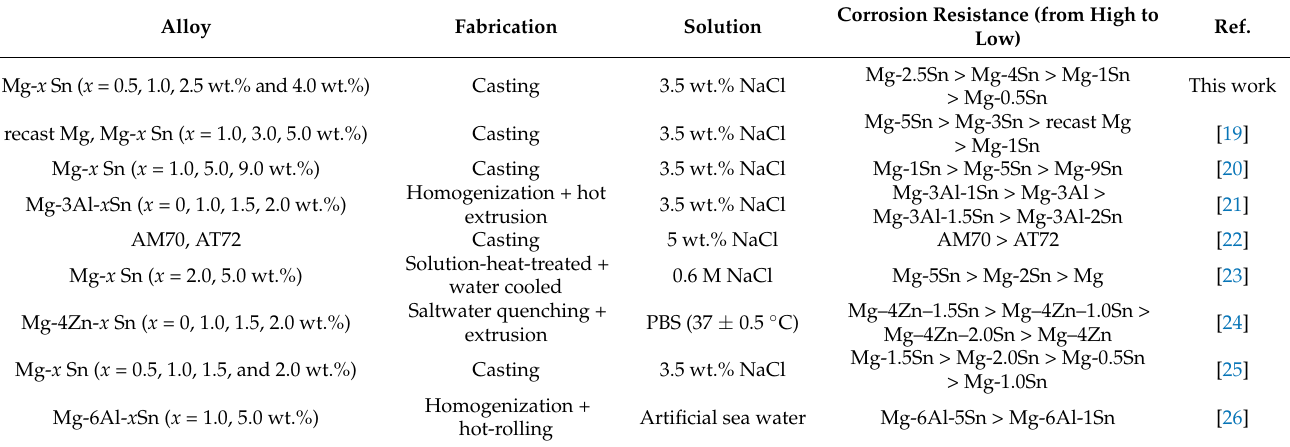
Table 4. Literature survey of electrochemical performance of several Mg-Sn-based anode